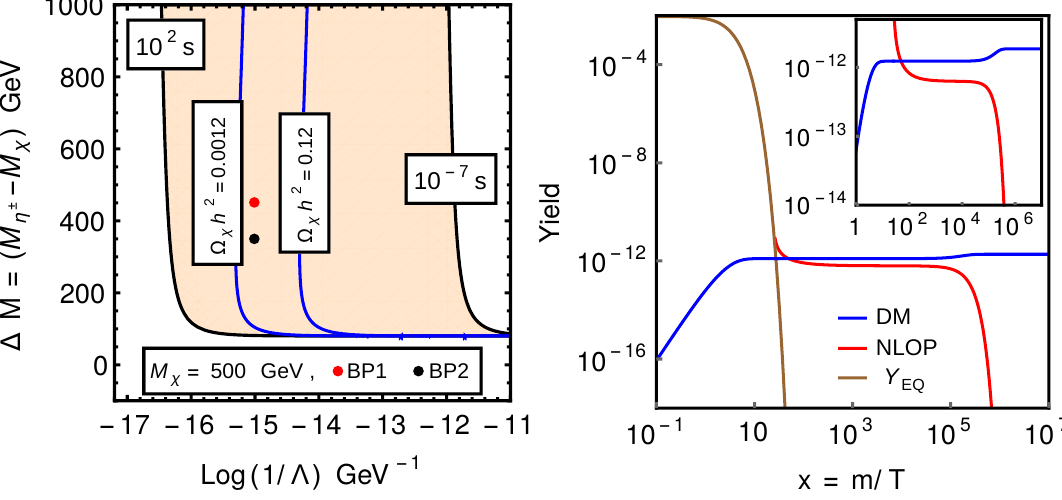
Figure 1 . Contours of life time of HSCP candidates (Black) and freeze-in relic density (Blue) of DM candidate (cid:31) as a function of mass di(cid:11)erence between NLOP and DM candidates and scale of new physics (cid:3) for Type III Seesaw model with sterile neutrino is shown in the left plot. Lower limit of the lifetime (10 (cid:0) 7 sec) is coming from the fact that the charged particle has to decay outside the detector whereas the upper limit of 100 sec is coming from BBN constraints. The current data of CDM relic density put constraints on the parameter space. The benchmark points we have used for the collider analysis are represented as the black and red points. Right panel shows the yield of the DM candidate (Blue) and NLOP (Red) as a function of ( x = m ), where m is the mass of the T NLOP. We have assumed M (cid:6) = 1 TeV and M (cid:23) = 500 GeV. The brown curve shows the equilibrium s distribution of the NLOP. The e(cid:11)ects after freeze-out of NLOP is magni(cid:12)ed in the